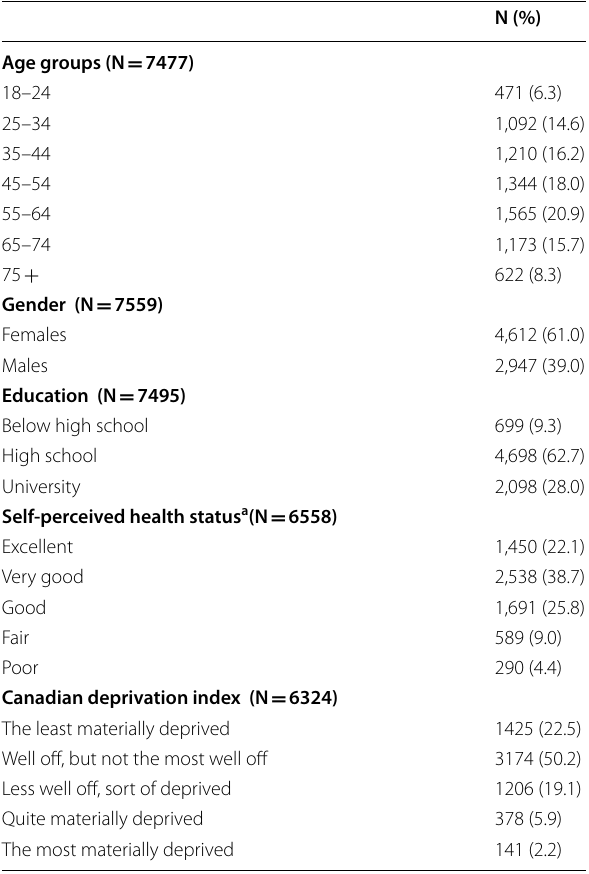
Table 1 General characteristics of participants of the